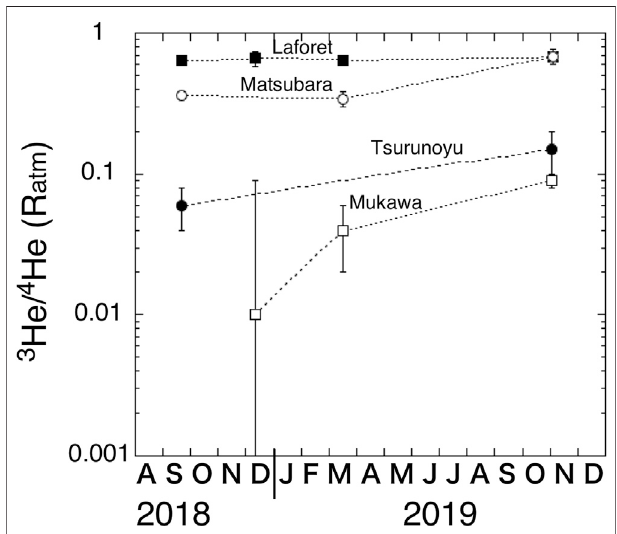
FIGURE 6 | Temporal variations of air-corrected 3 He/ 4 He ratios and normalized to the air ratio (Ratm (cid:2) 1.382 × 10 − 6 ), measured in natural springs after the M6.7 earthquake at Mukawa, Tsurunoyu, Matsubara, and Laforet in Hokkaido, Japan. Error bars are 2 σ .